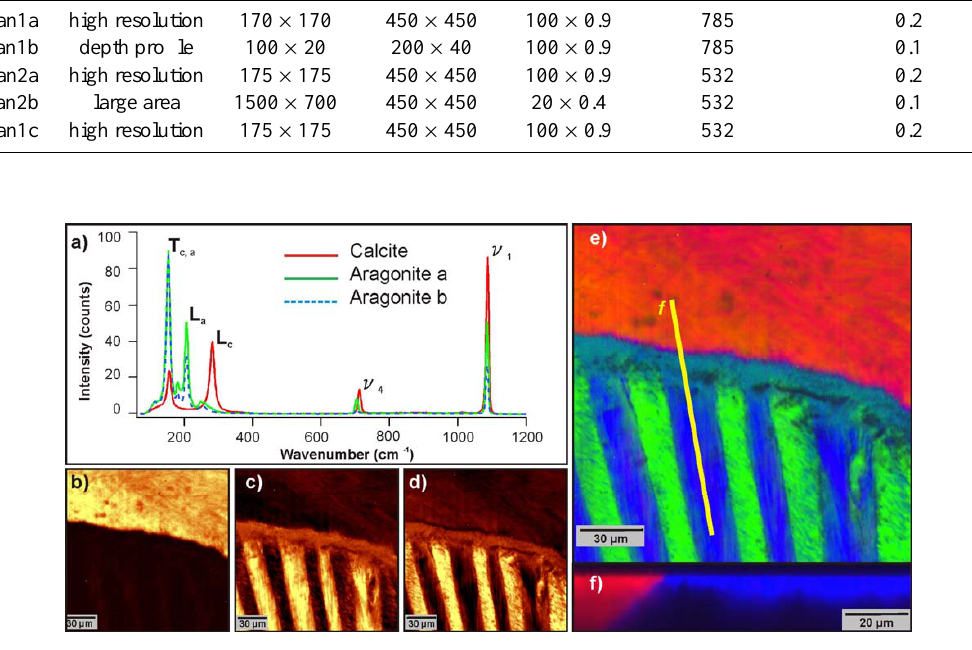
Fig. 2. (a) Raman spectra of calcite and aragonite extracted from scan1a (aragonite a and aragonite b are related to different crystallographic orientations). (b) Map showing the distribution of calcite across the area scanned in scan1a (scale bar = 30µm). (c) Map showing the distribution of aragonite a across the area scanned in scan1a (scale bar = 30µm). (d) Map showing the distribution of aragonite b across the area scanned in scan1a (scale bar = 30µm). (e) False color composite of maps b, c, and d. Line f marks the transect, along which a depth scan (scan1b) was performed. (f) False color composite showing the vertical distribution of calcite and aragonite along transect f (Fig. 2e) determined from